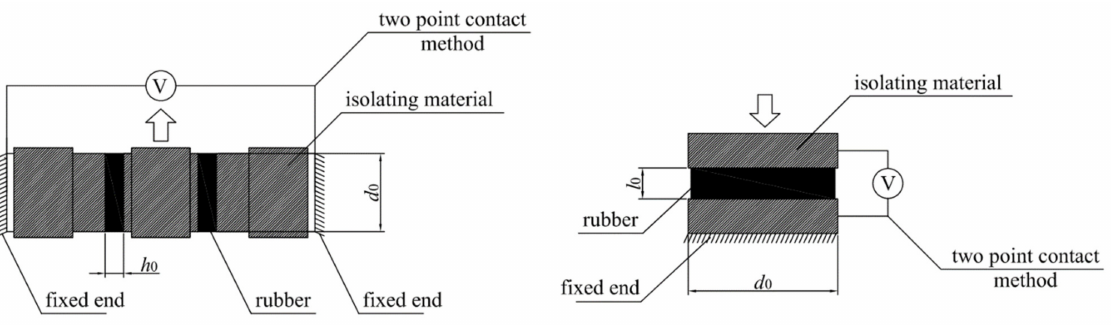
Figure 5. A schematic illustrating the two − point probe electrical resistance measurement technique for DBS and compressive